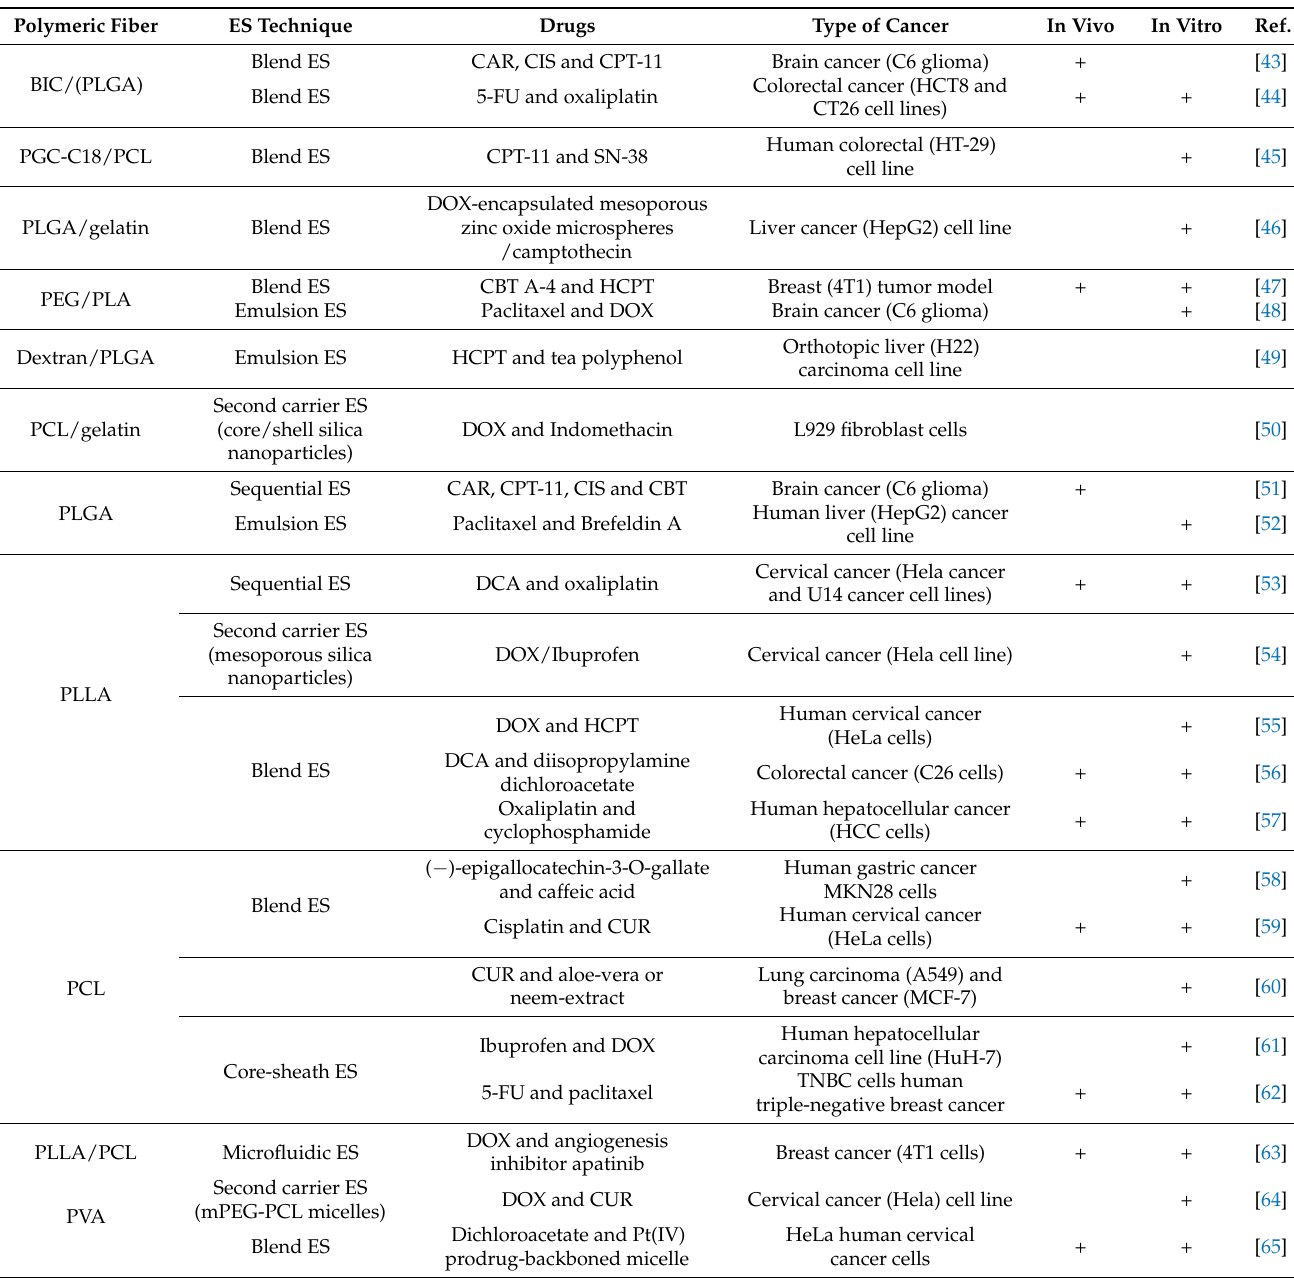
Table 1. Multidrug-loaded electrospun NF implants for cancer